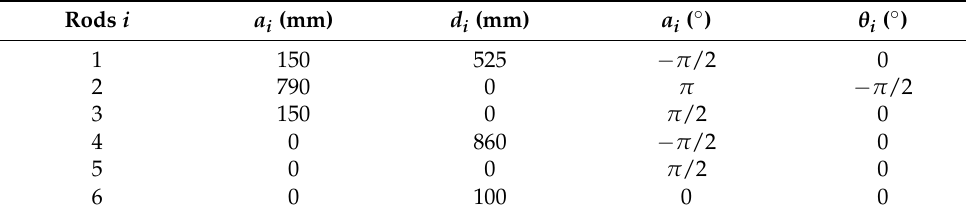
Table 2. Six-axis robot D–H parameter table.